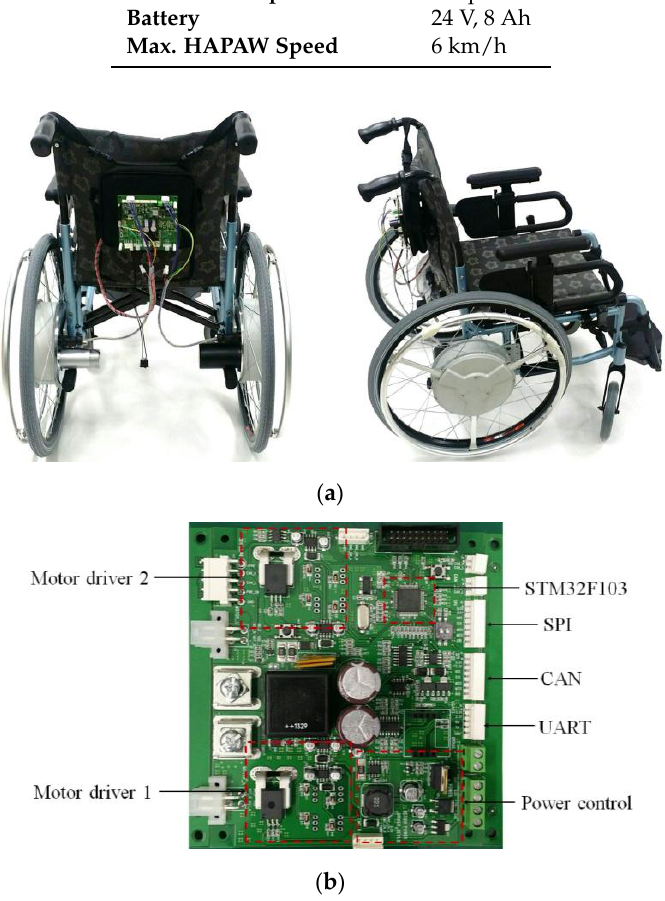
Figure 9. Prototype of the proposed device. ( a ) The assembled HAPAW and ( b ) the implemented motor driver.